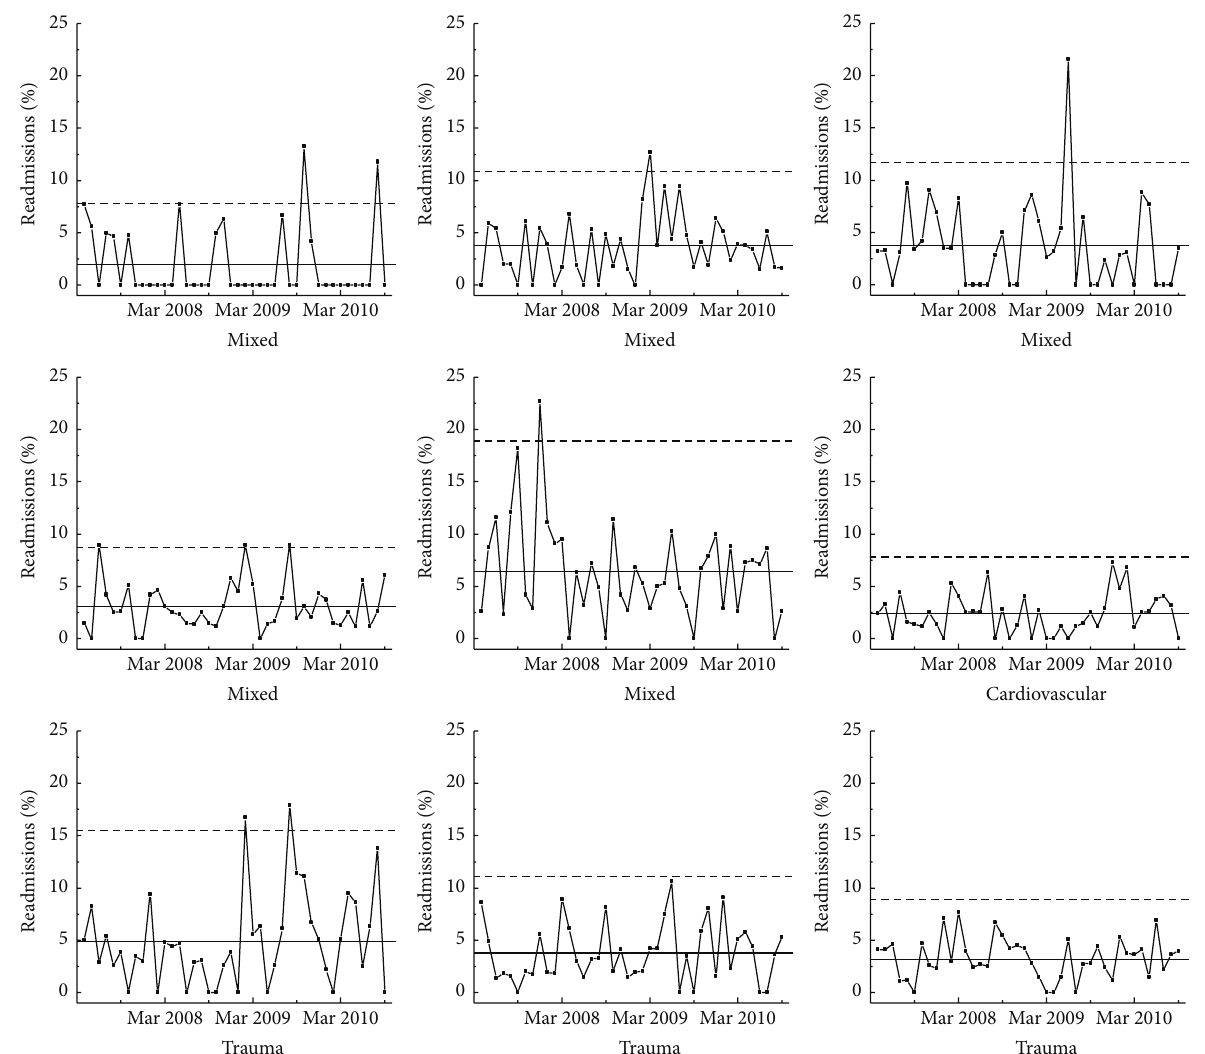
Figure 1: Percent readmissions per month as p-charts in small multiples. Statistical process control p-chart of readmission rate over time shown for 9 units as small multiples. The mean is shown as a solid line and the upper control limit (3 𝜎 ) as the dashed